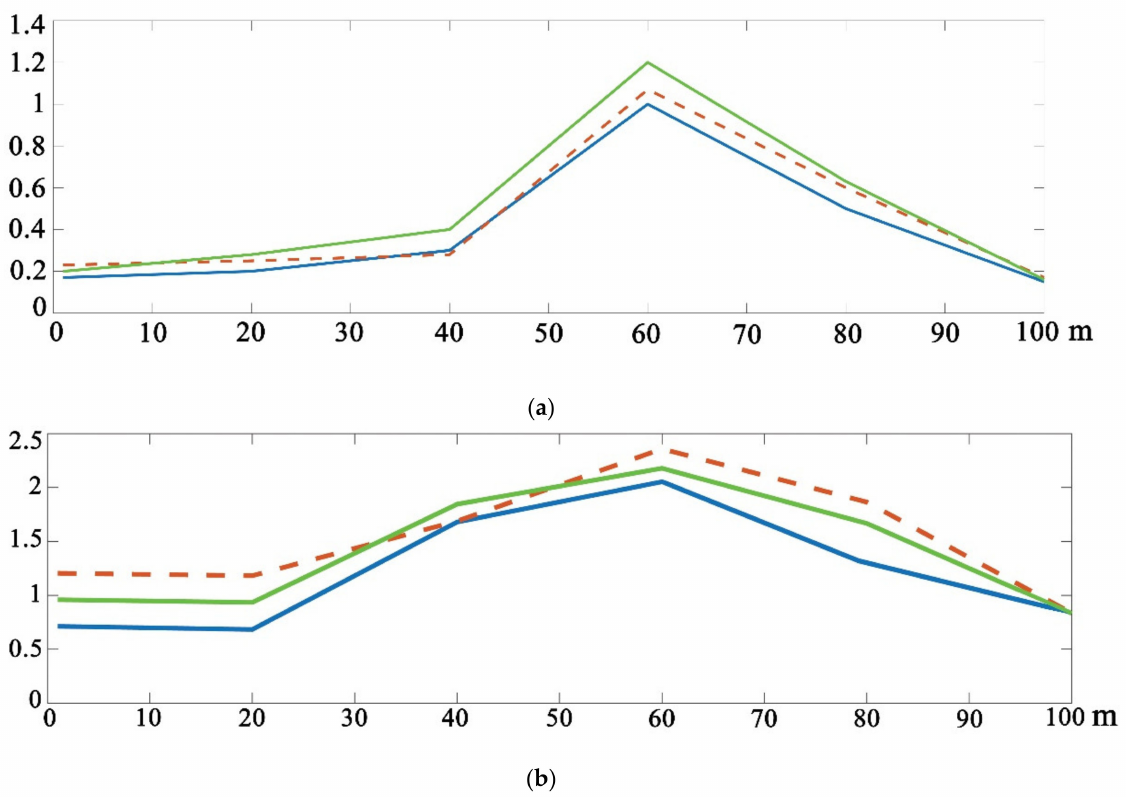
Figure 6. The difference between the results of computation of salinity ( a ) (‰) and temperature ( b ) ( ◦ C) (on 27 January 2010: control run (green line); assimilation by EnOI (orange dashed line); assimilation by GKF (blue line) with respect to the PIRATA mooring data.